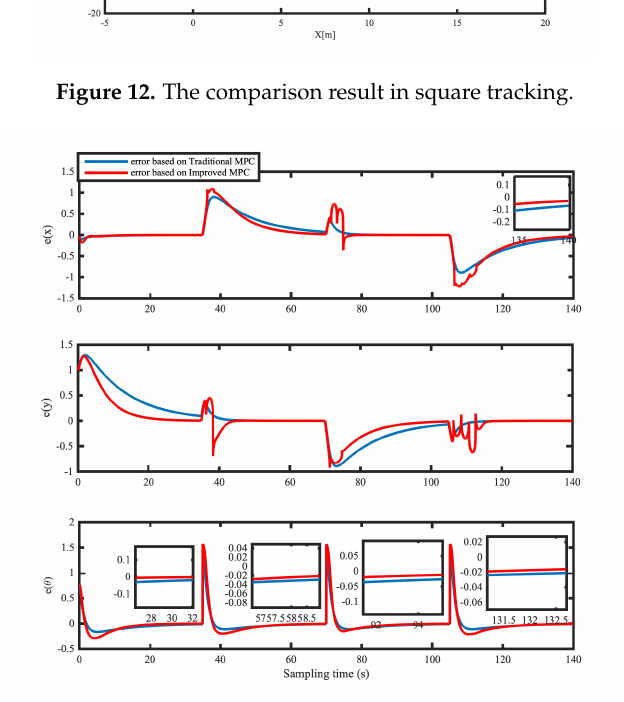
Figure 13. The comparison of the state errors in square tracking.